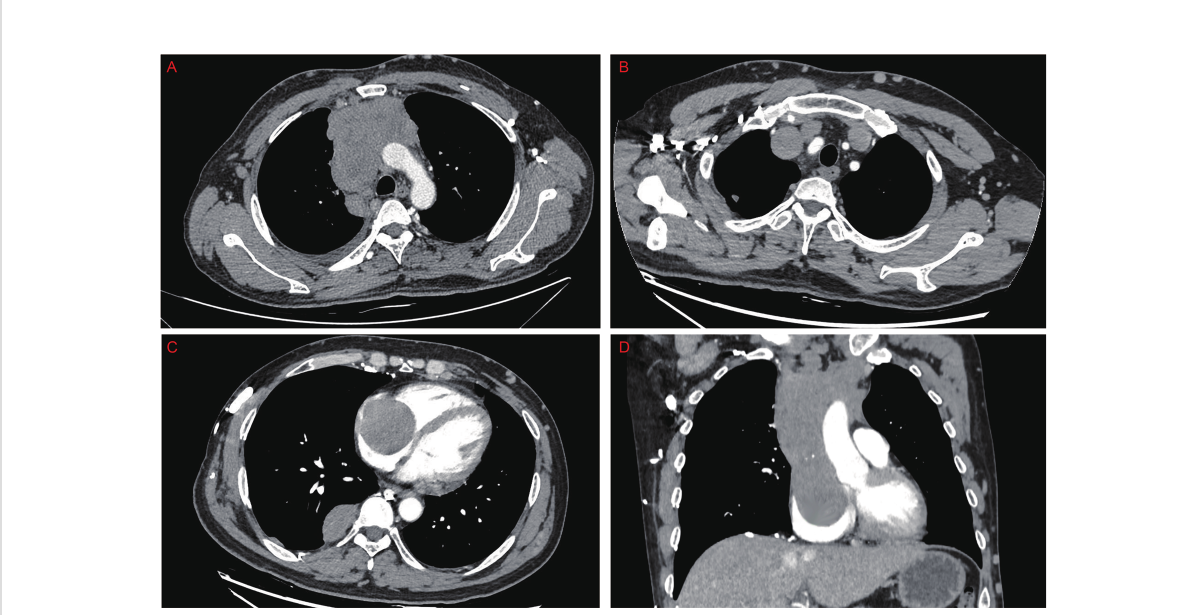
FIGURE 1 Preoperative computed tomography showed that the thymoma located in the anterior mediastinum (A) invaded the bilateral innominate veins, the superior vena cava, and the right atrium (B – D)